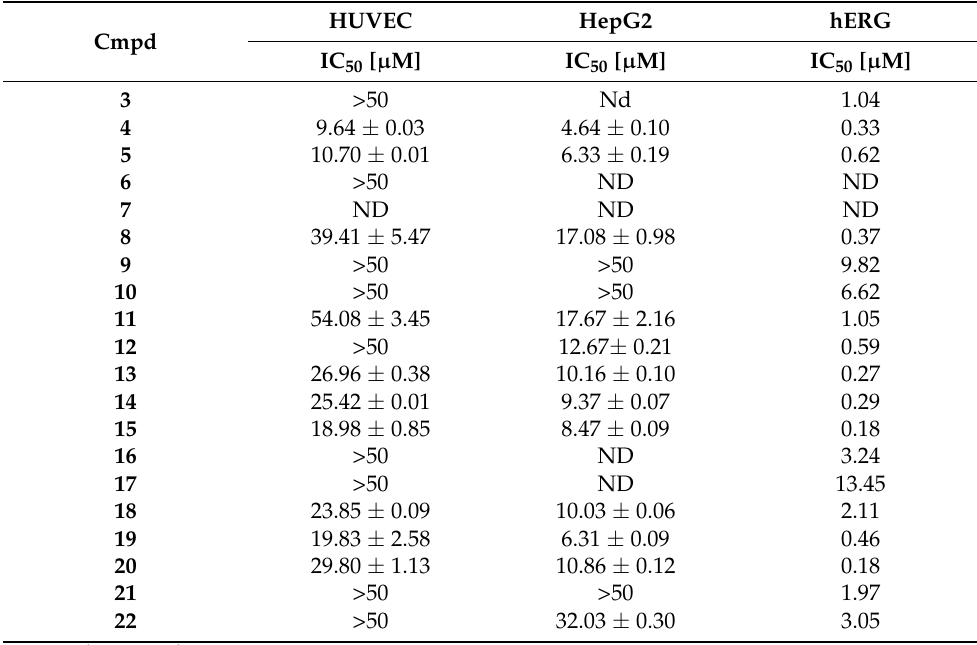
Table 4. Results of cytotoxicity on human HUVEC and HepG2 cell lines and hERG-related